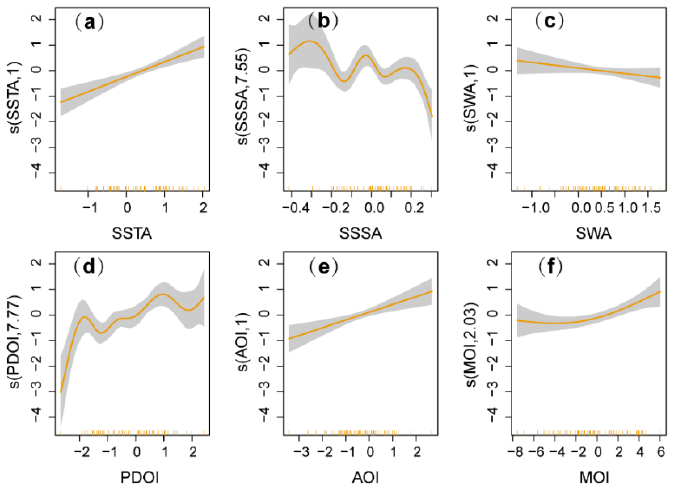
Figure 8. Generalized additive models (GAMs) for anchovy catch and environmental variables and climate indices in Japan. ( a ) Anchovy versus Sea Surface Temperature anomaly (SSTA). ( b ) Anchovy versus Air Temperature anomaly (ATA). ( c ) Anchovy versus Scalar Wind anomaly (SWA). ( d ) Anchovy versus Pacific Decadal Oscillation index (PDOI). ( e ) Anchovy versus North Pacific Gyre Oscillation index (NPGOI). ( f ) Anchovy versus Monsoon Oscillation index (MOI). Tick marks on the x -axis represent observed data points. Y -axis represents the smooth fitted function of the dependent values and is centered to zero. The values in parentheses in the y -axis label indicate the degree of freedom of the model.